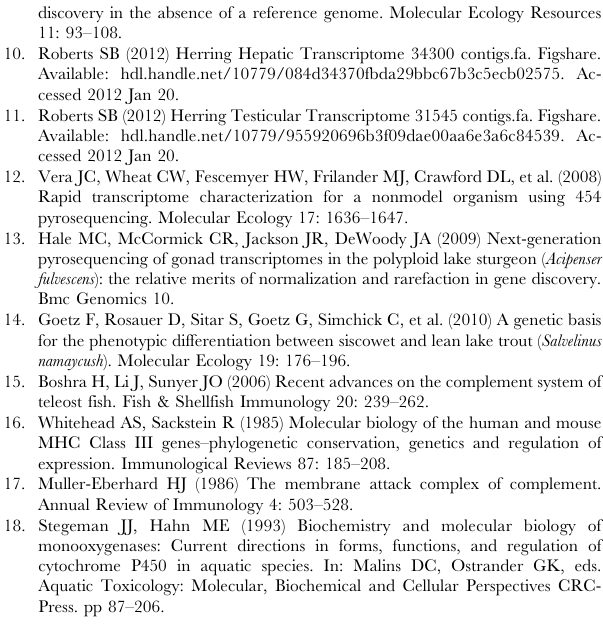
Table S1 Description of select contig sequences. De- scription is based on BlastX analysis using the Swiss-Prot database. E-values and organism associated with BlastX hits are provided as are the number of unique reads that map to each